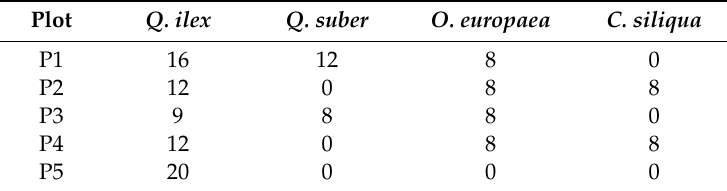
Table 1. Number of branches of each tree species collected in each sampling plot (P). Plot Q. ilex Q. suber